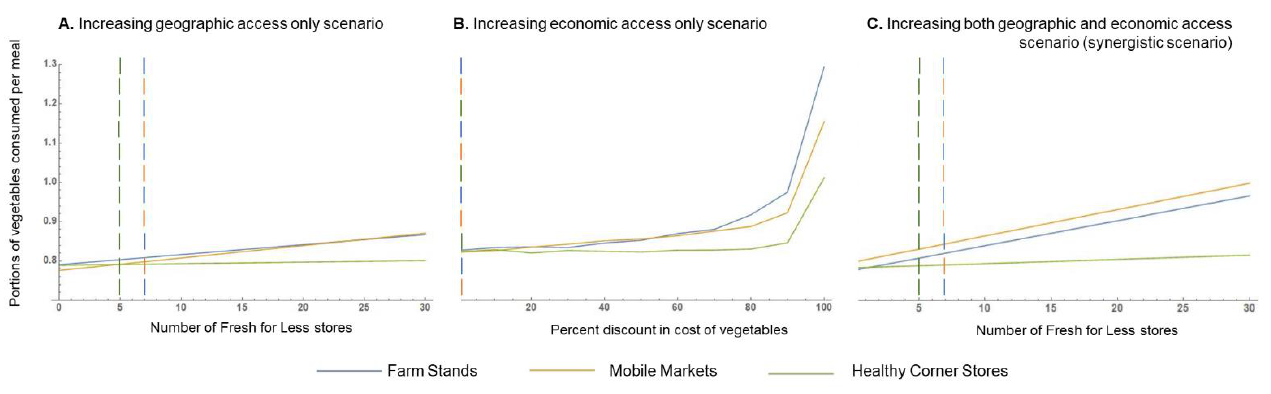
Figure 4. Agent-based model simulation results for Fresh for Less policy expansion scenarios.